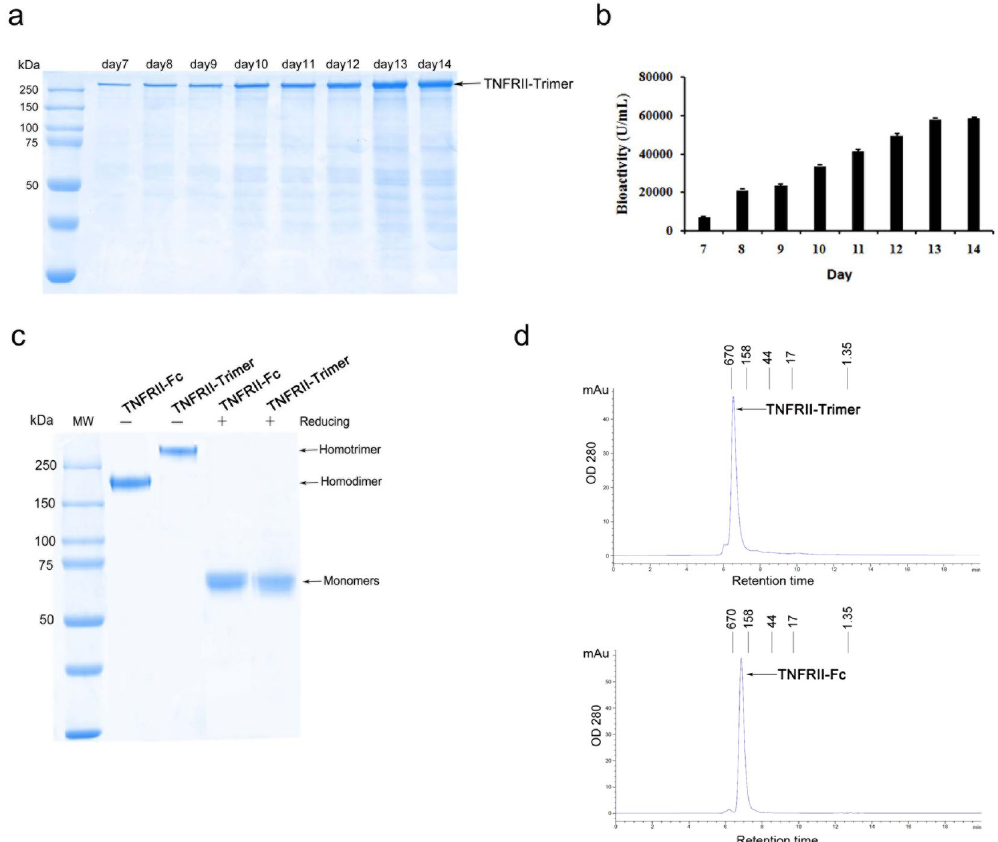
Figure 2. High-level expression and purification of TNFRII-Trimer fusion protein. ( a ) 10% SDS-PAGE analysis of TNFRII-Trimer expression from a fed-batch serum-free cell culture in the bioreactor. 10 μ l of cell-free conditioned medium from day 7 to day 14 were analyzed under non-reducing condition followed by Coomassie brilliant blue staining. ( b ) Bioassay analysis of TNFRII-Trimer production in conditioned medium from day 7 to day 14. ( c ) SDS-PAGE analysis of purified TNFRII-Trimer under either non-reducing or reducing conditions with TNFRII-Fc as a control. TNFRII-Fc (2 μ g) and purified TNFRII-Trimer (2 μ g) were analyzed by a 10% SDS-PAGE and stained with Coomassie Blue. ( d ) Purity evaluation of TNFRII-Trimer by SEC-HPLC, with OD280 detection. TNFRII-Fc served as a control. The main peak area of TNFRII-Trimer was